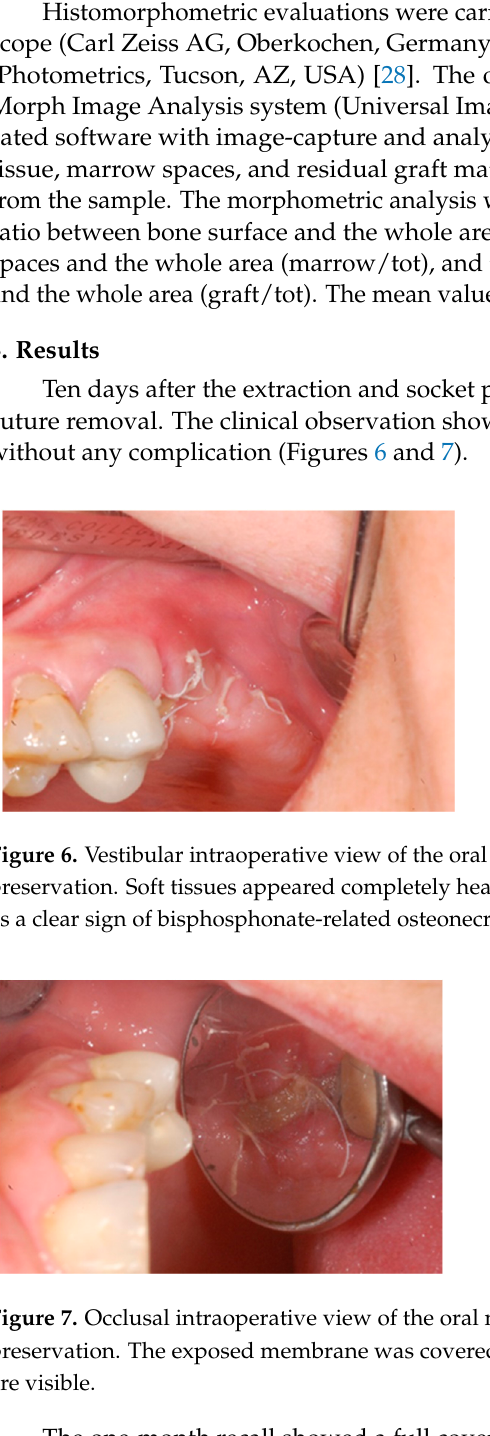
Figure 8. Intraoperative view of the oral mucosa at one month post tooth extraction. Soft tissues appeared to be completely healed with no signs of bone exposition, considered as a clear sign of BRONJ. Five months after the extraction, a cone-beam computed tomography (CBCT) was also performed to design the implant insertion. The radiological examination showed bone volume preservation of the post-extraction site and no signs of osteonecrosis (Figures 9 and 10). Figure 9. Cone-beam computed tomography (CBCT) shows bone volume preservation in the mesial surface of the alveolus.